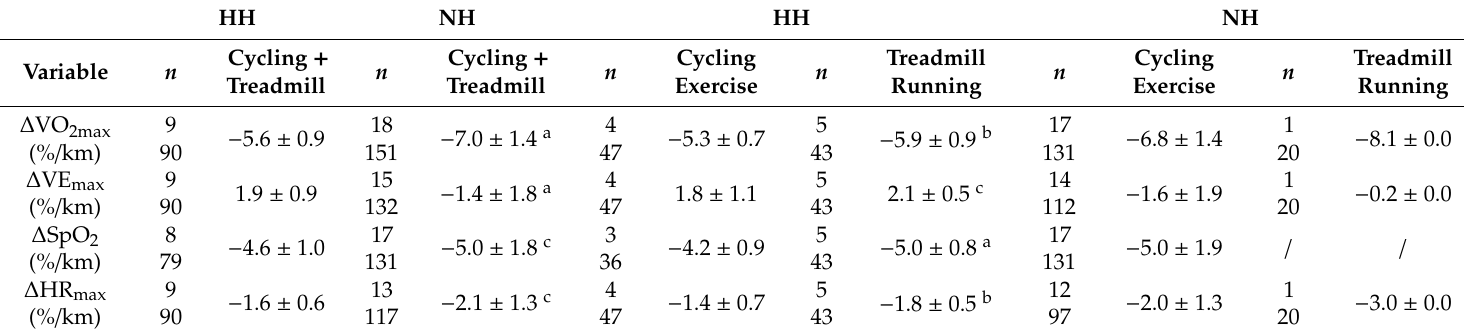
Table 3. Changes for each 1000 m altitude climb separately shown for altitude conditions and exercise